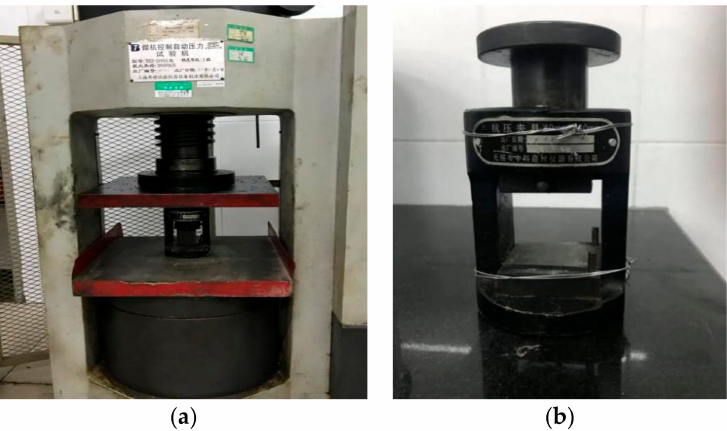
Figure 4. Settings of the compressive strength test. ( a ) Setup of compression test; ( b ) Test